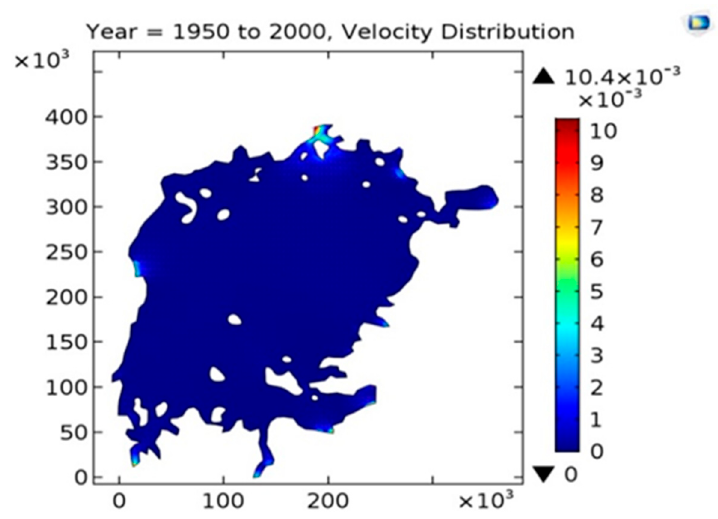
Figure 11. Mean flow velocity.